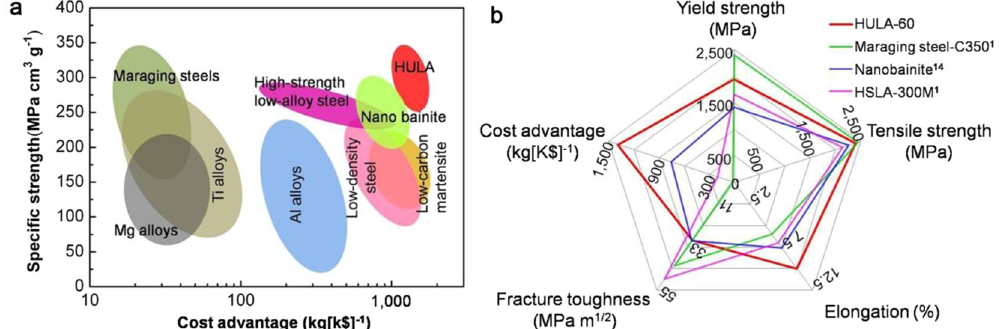
Figure 2. Comparison of mechanical properties and cost advantage of HULAs with other alloys and steels. ( a ) Specific strength versus the cost advantage (kg per thousand US dollars). ( b ) Comparison of tensile strength, yield strength, fracture toughness, elongation, and cost advantage for HULA-60 and several typical ultrahigh strength steels with yield strength exceeding that of low-grade Maraging steel (1700 MPa). The price